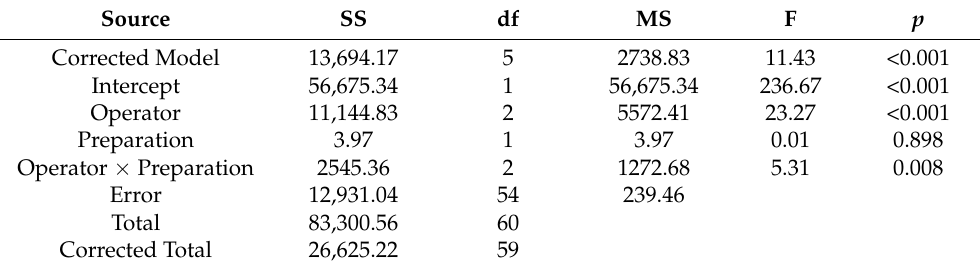
Table 3. Results of 2-way ANOVA.